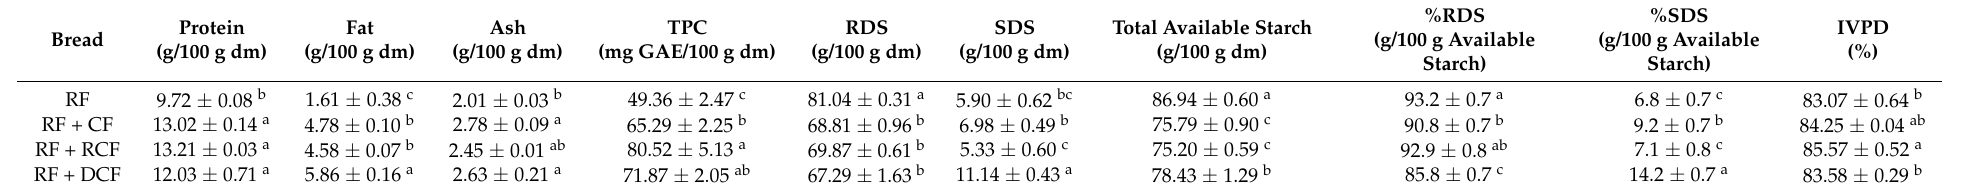
Table 3. Nutritional properties of gluten-free